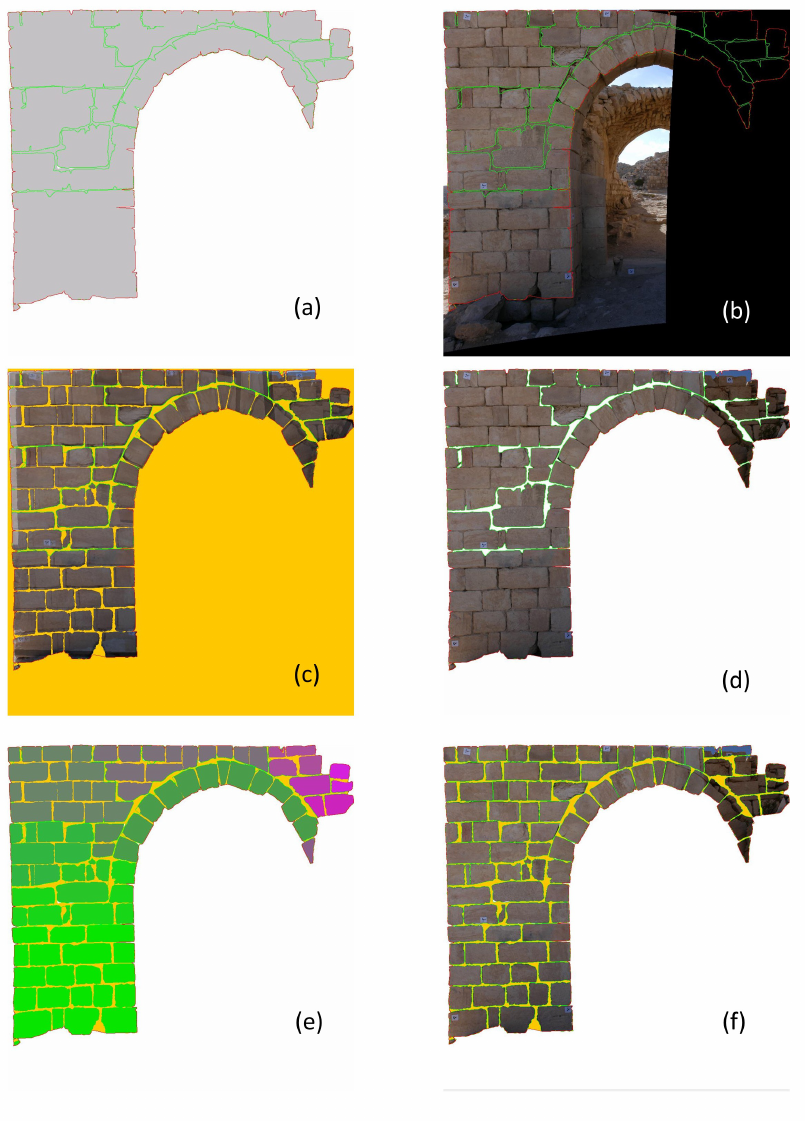
Figure 9. Several orthophoto/map generation images based on several queries: ( a ) the design of USM perimeters; ( b ) same as (a) with a reprojection of one of the oriented images; ( c ) Image (a) with a reprojection of the texture inside the block perimeter; ( d ) texture reprojection inside of the US perimeter (computed with blocks); ( e ) Image (a) query with a uniform color inside each block according to their US and an automatic extraction of the cement (computed as the Boolean difference between the global perimeter of all US and all the individual blocks); ( f ) the same as (e), but with texture mapping for each